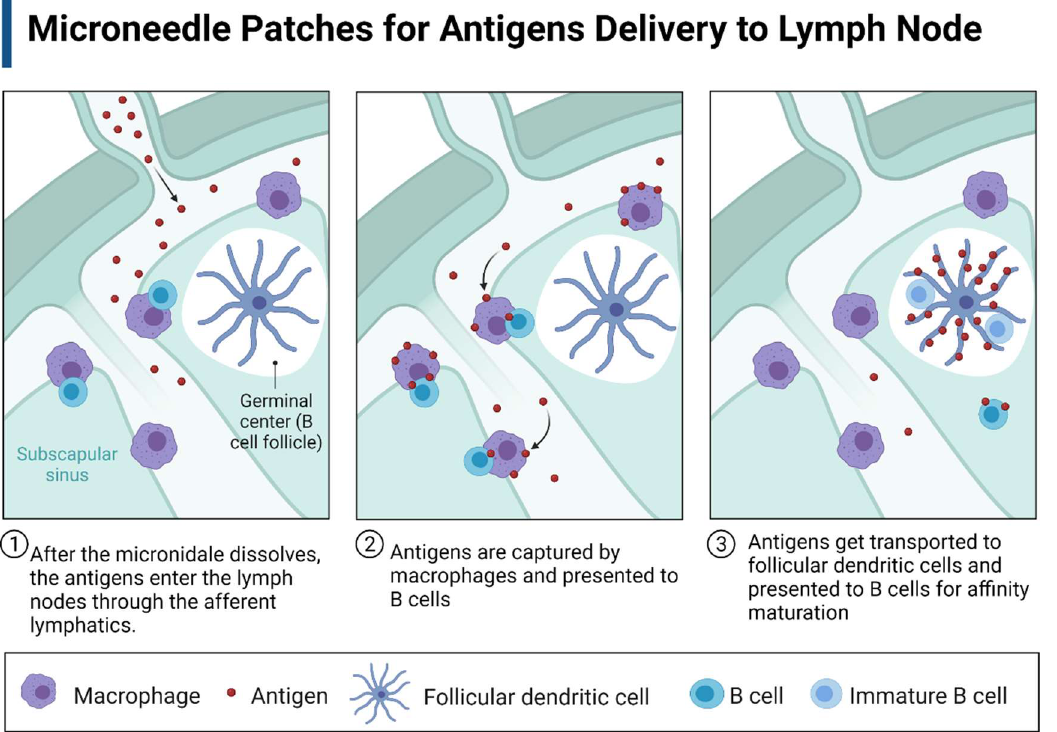
Figure 3. Microneedle scaffold-based tumor-specific antigen delivery to the lymph node. (1–3) B cells encounter antigen and process it.